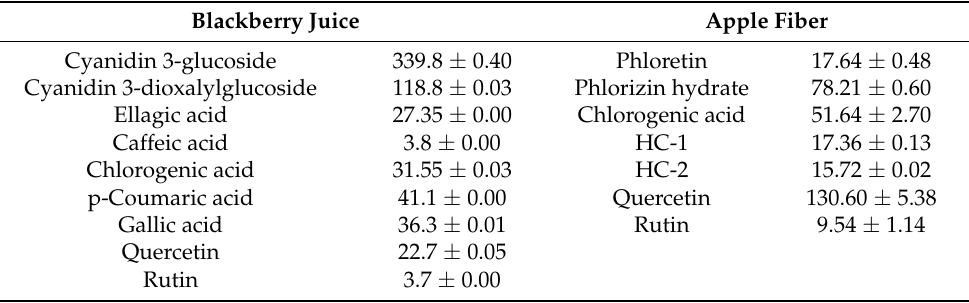
Table 2. Individual phenolic compounds (mg/100 g) of blackberry juice and apple fiber.